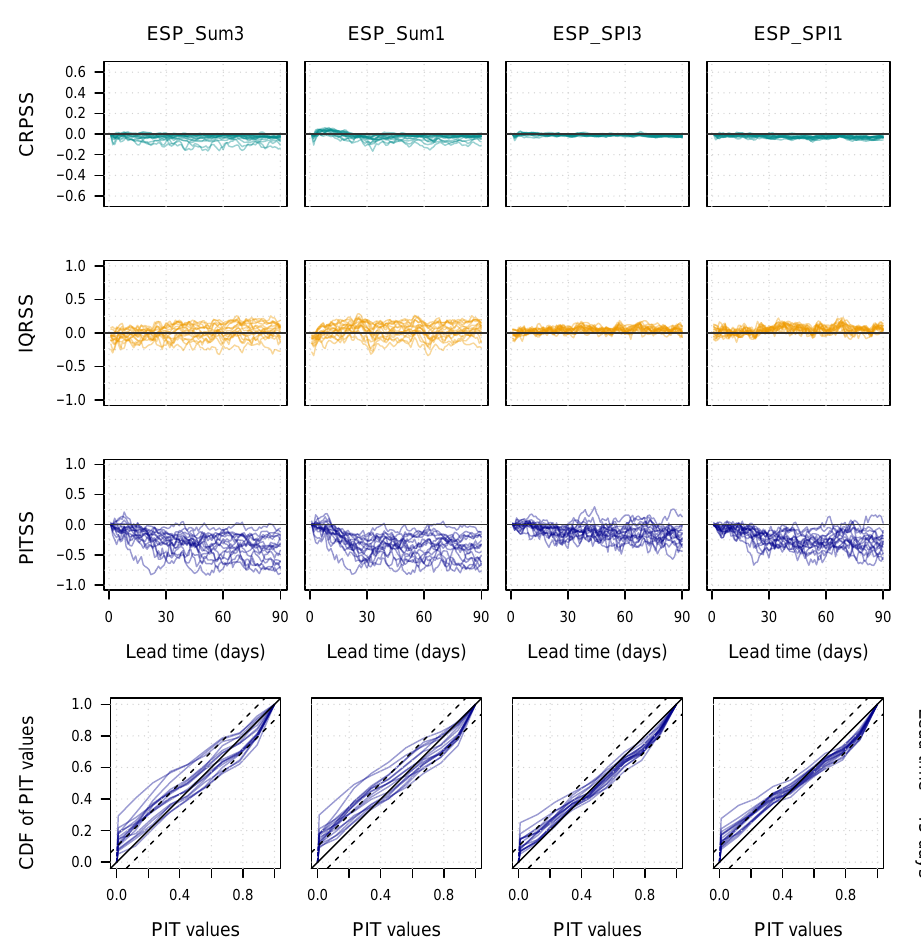
Figure 5. Same as Figure 4 but the forecast ensembles are ESP_Sum3, ESP_Sum1, ESP_SPI3 and ESP_SPI1 and the reference for the computation of the skill is